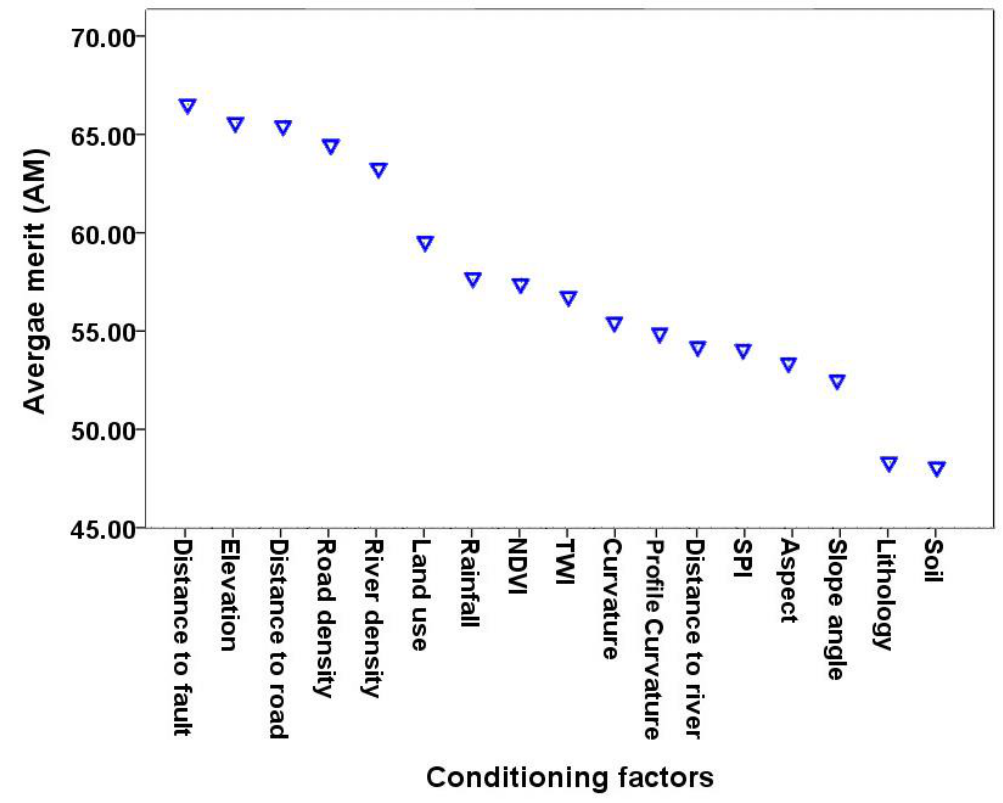
Figure 10. Factor importance measured using the One-R method.